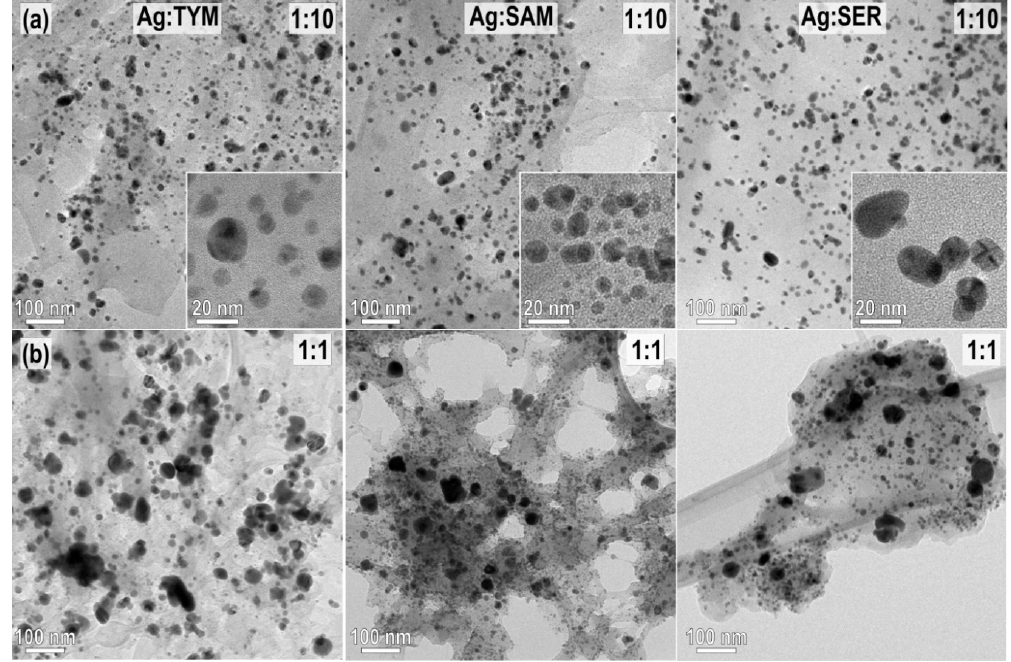
Figure 7. TEM images of the Ag:plant W samples ( a ) 1:10 and ( b ) 1:1. Insets in the ( a ) are magnifications showing the presence of AgNPs with sizes below 10 nm.